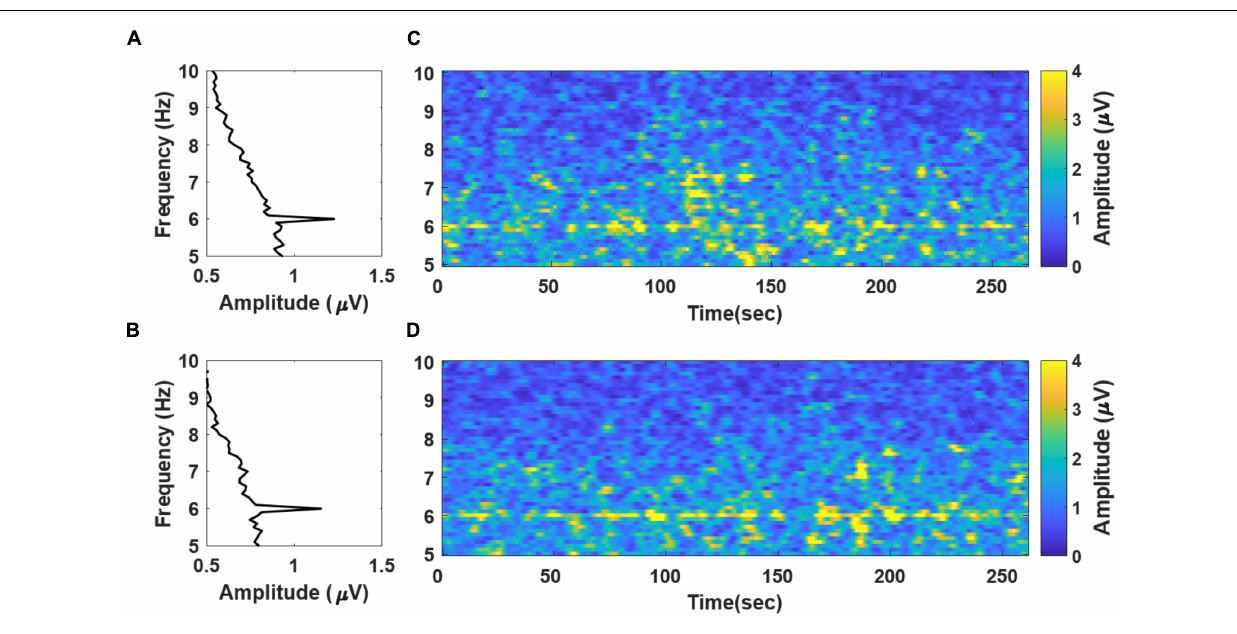
samples. The order of the polynomial regression was